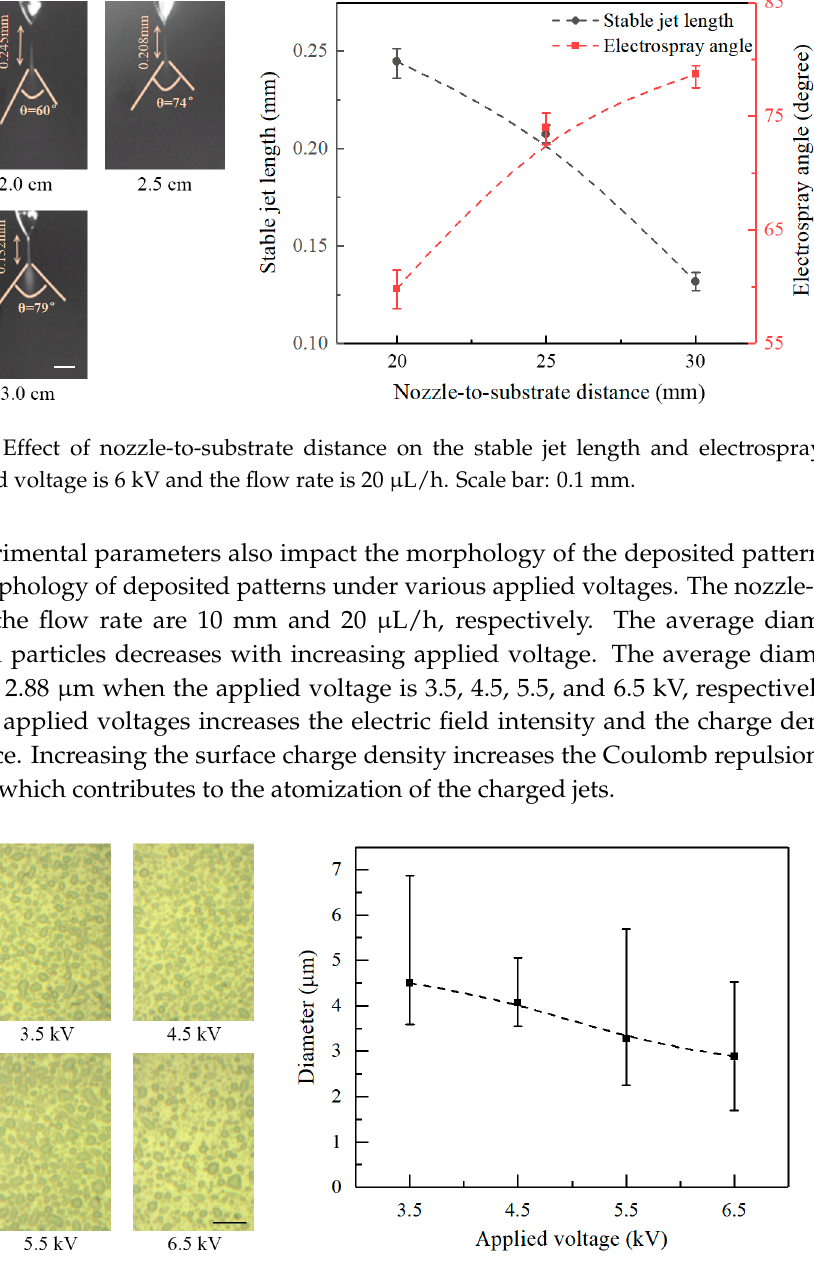
Figure 5. Effect of applied voltage on the diameter of the electrosprayed particles. The nozzle-to-substrate distance and the flow rate are 10 mm and 20 μ L/h, respectively. The optical photographs inset are the electrosprayed particles. Scale bar: 20 μ m.